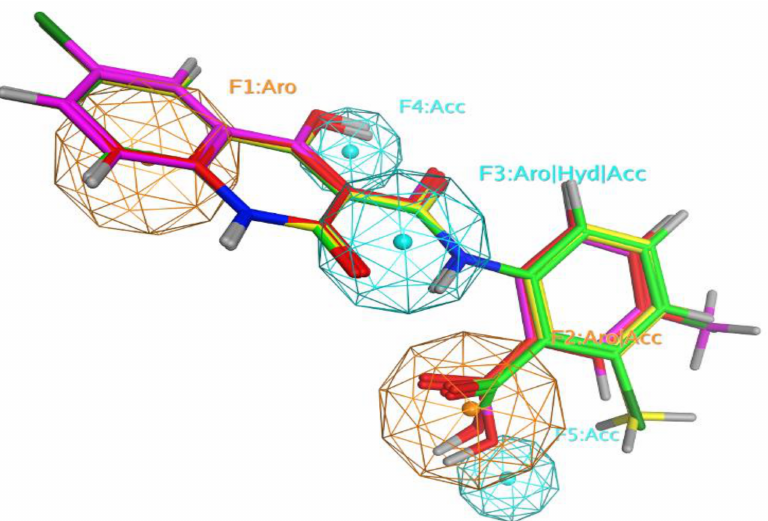
Figure 7. PI3K α inhibitors pharmacophore model with 14 (red color), 15 (green color), 22 (pink color), and 23 (yellow